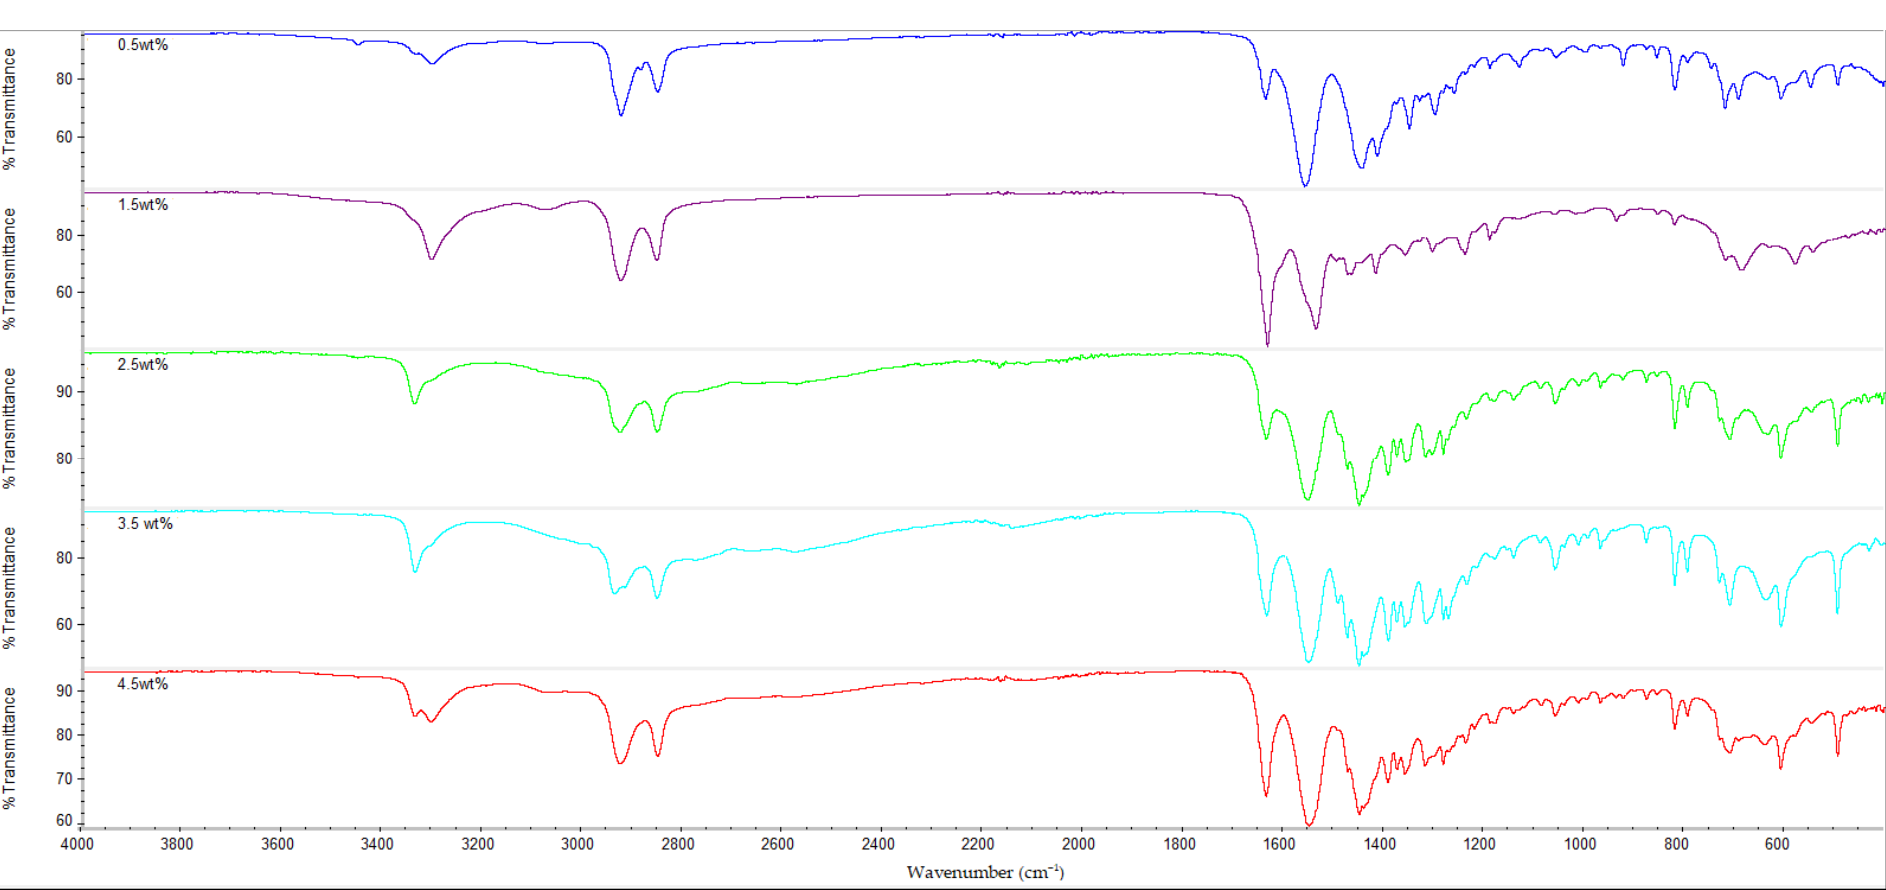
Figure 10. FTIR Spectra for Nylon 610 Nanocomposites with Graphite Nanosheets Treated at 200 °C and − 0.1 MPa.